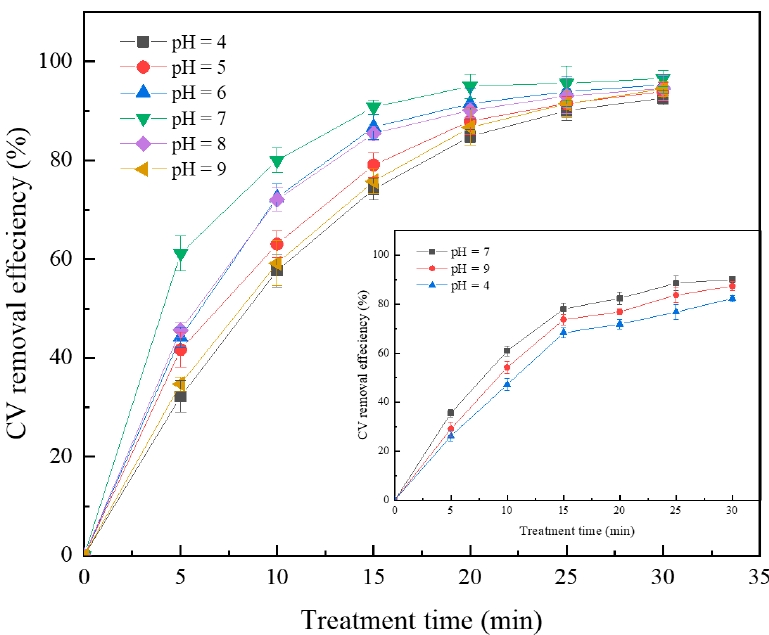
Figure 6. Effect of initial pH on the CV removal. The insert of Figure 4 displays the CV removal by plasma alone (initial CV concentration = 25 mg/L, discharge voltage = 22 kV, frequency = 50 Hz, aeration O 2 = 3.0 L/min, red mud dosage = 2.0 g, conductivity = 70 μ s/cm).